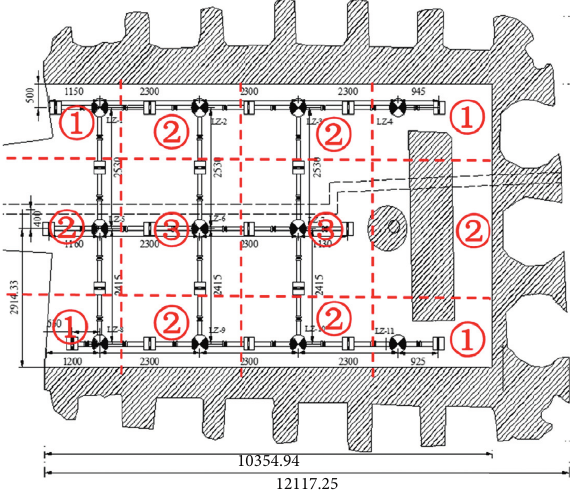
Figure 14: Schematic diagram of roof division. Table 1: Monitoring data and evaluation parameters of Yuanjue rock